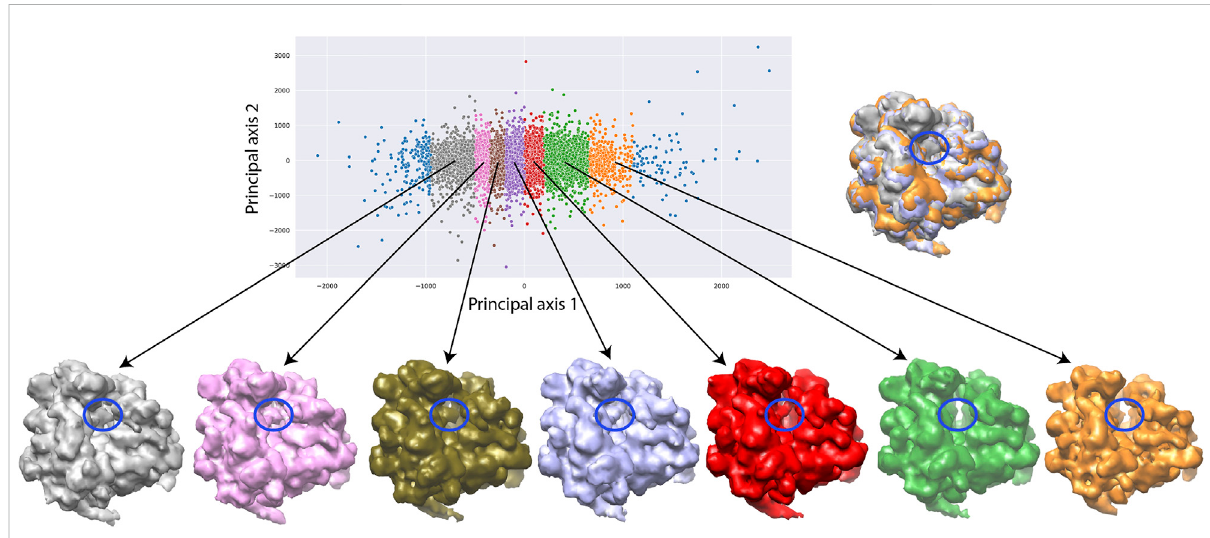
FIGURE 9 Two-dimensional conformational space of yeast 80S ribosome-tRNA complexes from the EMPIAR-10016 cryo-EM images, obtained by principal component analysis of normal-mode amplitudes inferred from 12,095 images (top, left), with 7 average conformations obtained by 3D reconstruction (bottom) from groups of images selected along the fi rst principal axis, and an overlap of the maps reconstructed from the fi rst (gray), fourth (violet), and seventh (orange) groups (top, right). The far left and far right images (blue) were not used for the reconstructions and the remaining part of the conformational space was split quasi-uniformly in the way to get at least 900 images per group. The reconstructions were obtained from 1,018, 1,148, 1,461, 1,816, 1,771, 975, and 949 images (bottom, from left to right). The color of the reconstructed map (bottom) correspondstothecolorofthegroupofpointsintheconformationalspace(top).Theblueellipseoverlappedwiththereconstructedmapsindicates the region where the additional mass, corresponding to the additional tRNA, is present or